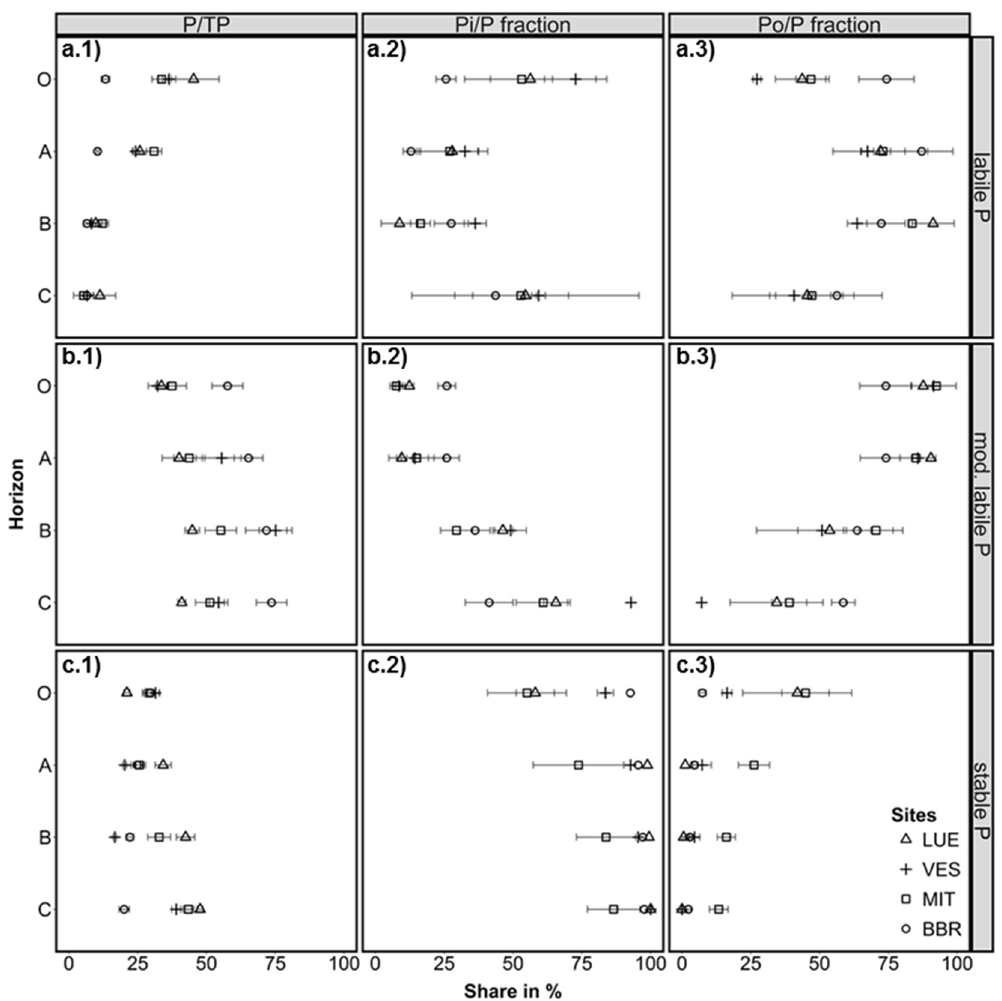
Figure 3. Share of a.1 ) the labile (resin ‐ P i + NaHCO 3 ‐ P i,o ), b.1 ) moderately labile (NaOH ‐ P i,o + HCl dil